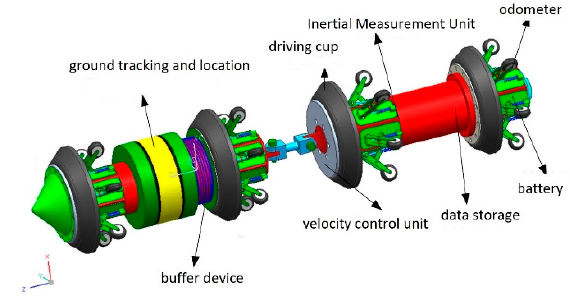
Figure 1. Pipeline centerline measurement system.